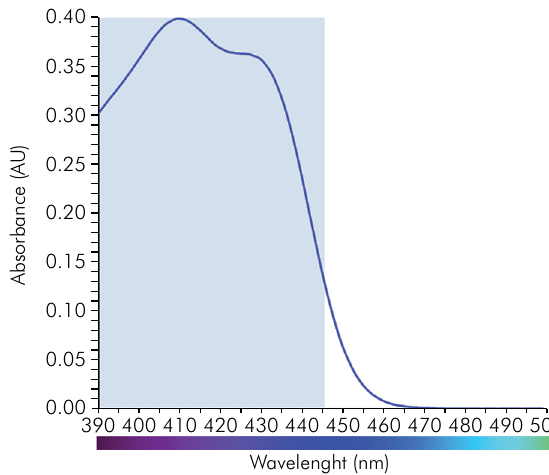
Figure 10. Visible light absorption of PPD, ranging between 390 to 460 nm.